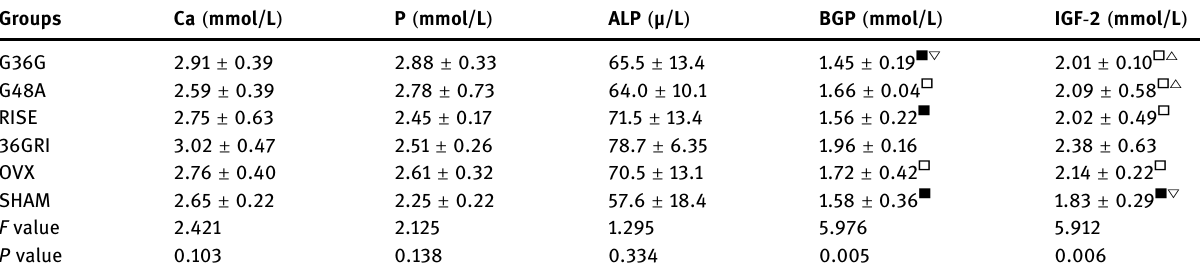
Table 2: Serum Ca, P, ALP, BGP, and IGF - 2 levels in di ff erent intervention groups after interventions ( x s ¯ ± )